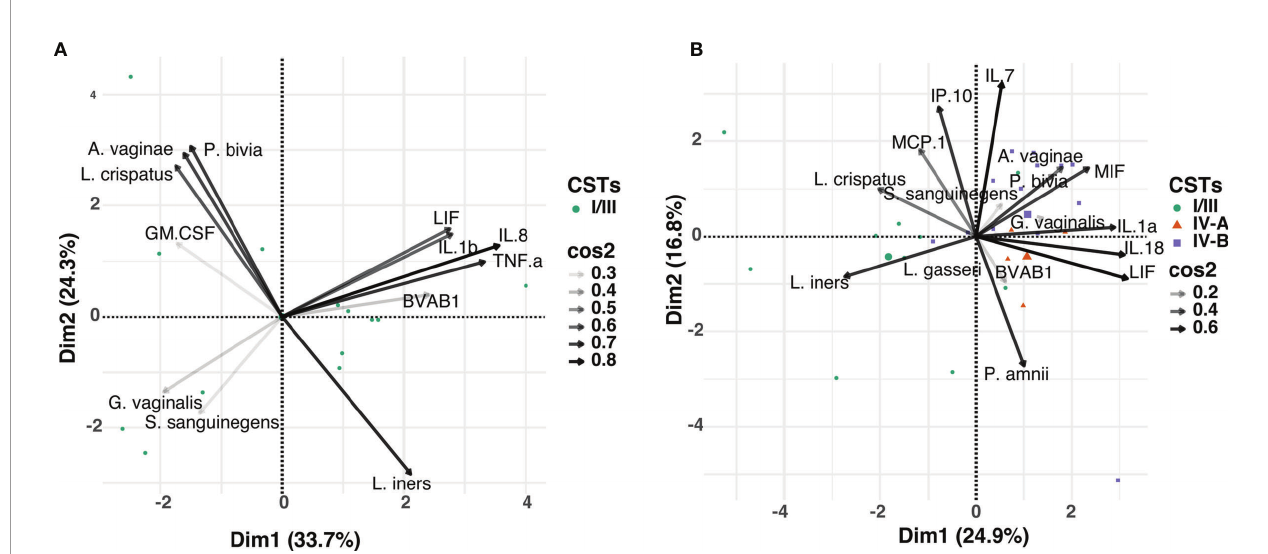
FIGURE 5 | Principal component analysis (PCA) showing the relationship between the relative abundance of the individual bacterial taxa and mucosal cytokines associated with BV, in: (A) women that cleared BV at 12 weeks post-treatment (n=13), and (B) those that had persistent BV (n=35). Data points represent the projection of participants on PCs 1 and 2 with colour and shape corresponding to their respective CST assignment. The arrows correspond to eigenvectors, which give a sense of the magnitude of the factors in the data set that drive the separation. The arrow length indicates the variance across the dataset and the angle between the arrows describes the correlation between the variables. The cos2 value of the variable indicates its contribution in driving the input data into principal components. Variables with large cos2 values contribute more to the distance separating the data points in the